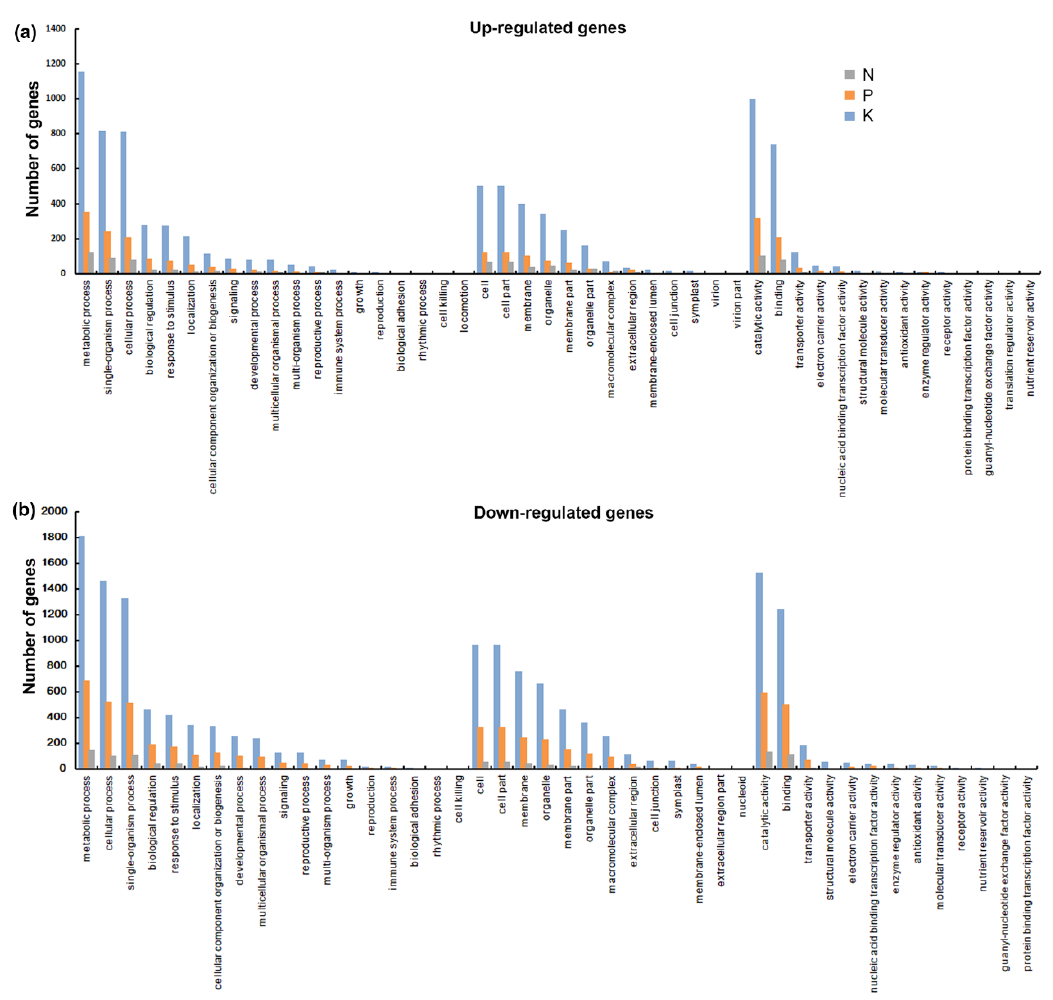
Figure 3. Gene Ontology (GO) annotation of di ff erentially expressed genes under N, P, and K starvation. ( a ) GO classification of up-regulated genes under N, P, and K starvation. ( b ) GO classification of down-regulated genes under N, P, and K starvation. The x -axis represents the GO classification and the y -axis represents the number of di ff erentially expressed genes mapped to the GO database.